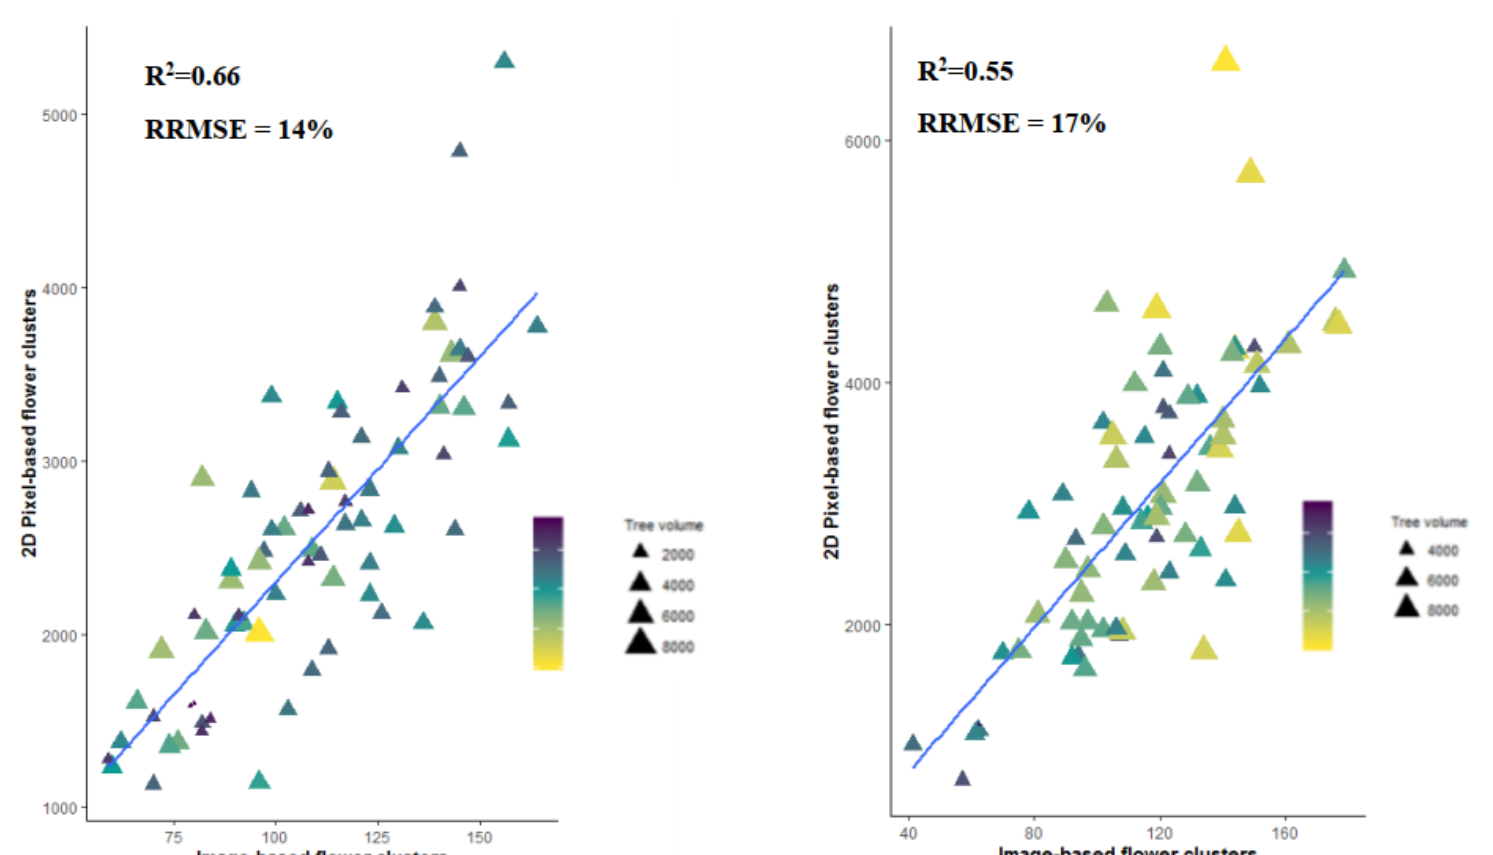
Figure A3. Correlation plot between the image-based flower clusters (FC p ) and the pixel-based flower clusters of Rummen (left) and Wimmertingen (right) (FC p *); the tree volume in cm 3 is visualized by the symbol size and color of the datapoints 225